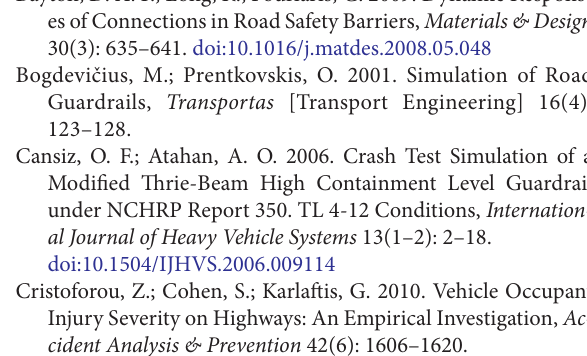
Fig. 7. Safety barrier simulation with rigidly belted Hybrid III